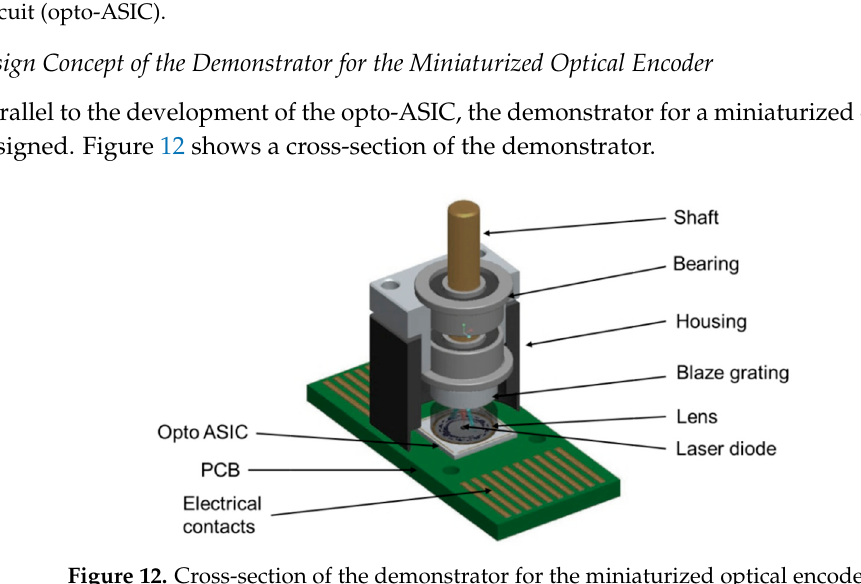
Figure 11. Read-out circuit of the segmented photodiode an optical application-specific integrated circuit (opto-ASIC).